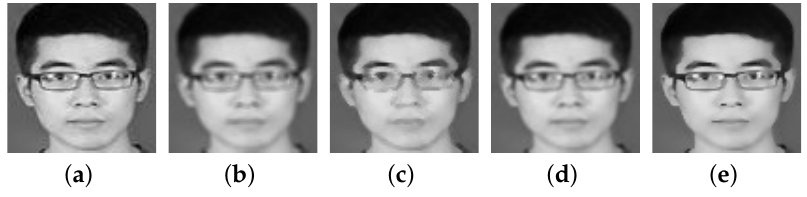
Figure 4. Filter operation. ( a ) The original face image. ( b ) Result of using a mean filter. ( c ) Result